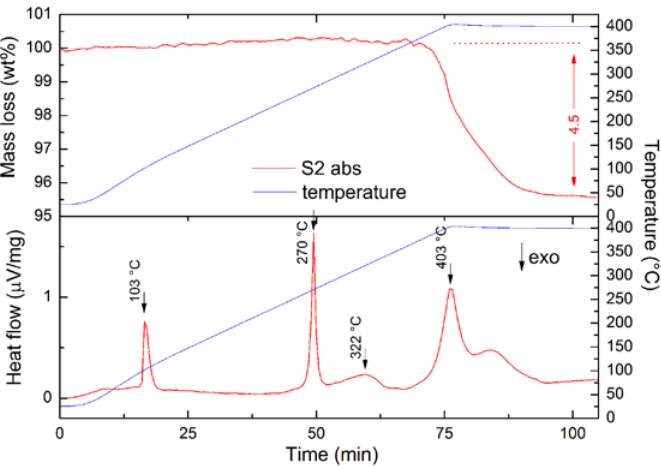
Figure 6. TG (top) and DSC (bottom) data of S2 after the first reabsorption. The x -axis is in time (min) as the measurement proceeds isothermally for 30 min after the heating ramp. Temperature ( ◦ C) is shown on the y -axis to the right.